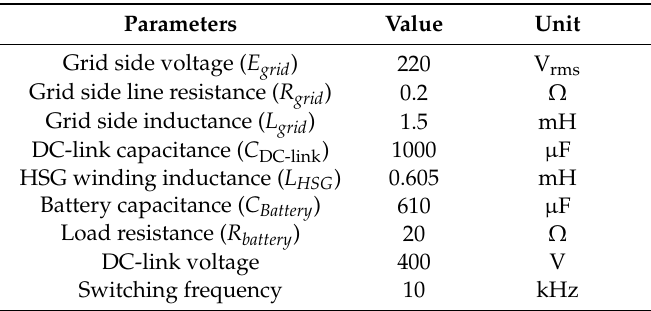
Table 4. Simulation